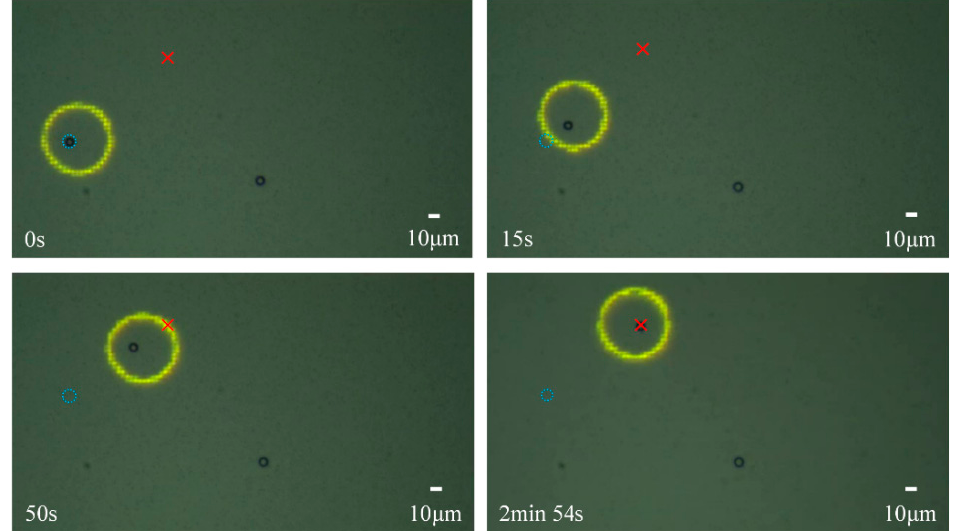
Figure 6. Moving process of the microsphere manipulation based on the designed control system. The yellow circle is the optical pattern, the red “×” is the target point and the blue dotted circle is the initial position.